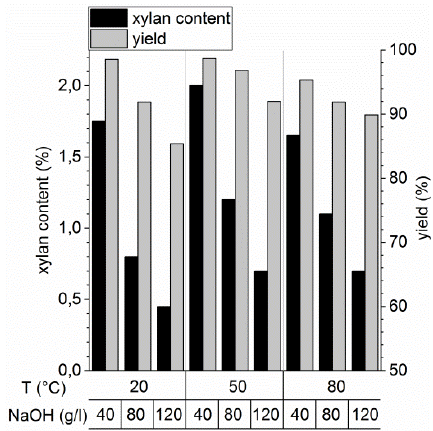
Figure 2. The xylan content of extracted sulphite pulp in correlation to temperature and NaOH concentration.